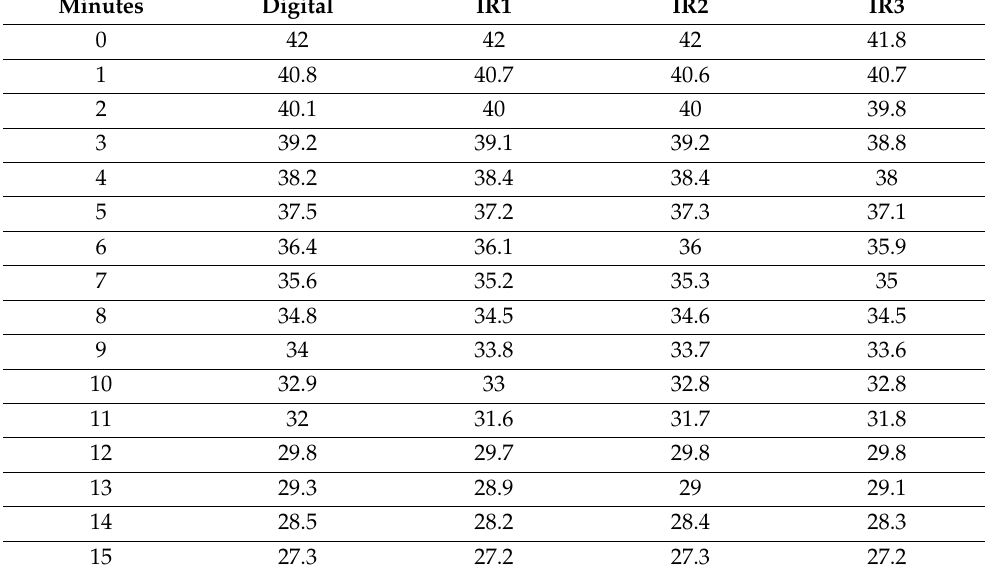
Table 1. Temperature ( ◦ C) recorded for the accuracy assessment of the different thermometers used during the experimental protocol. The temperature of a preheated object was recorded for 15 min during its thermal recovery every 1 min by means of digital and infrared (IR)